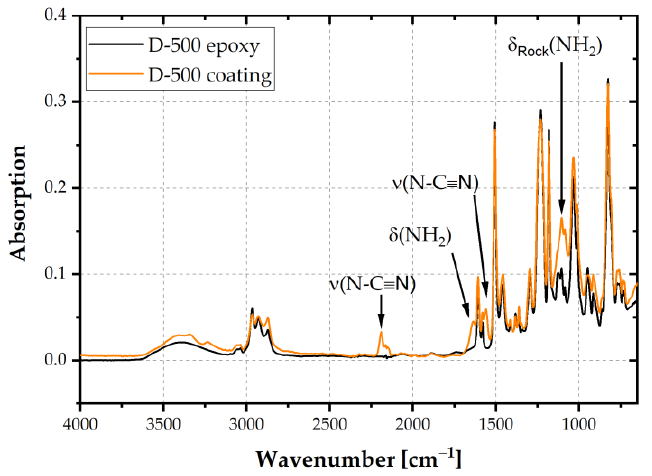
Figure 5. FTIR-ATR spectra of the epoxy resin D-500 and the coating in B-stage.